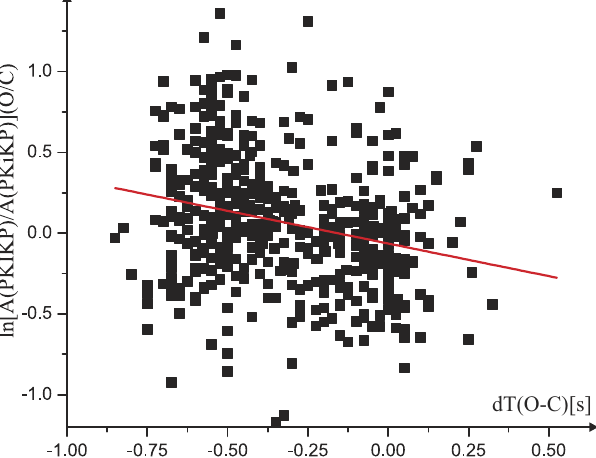
Figure 2. Natural logarithm of the amplitude ratio values of PKIKP/PKiKP (Observed/Computed) vs. the differential times from 548 high ( > 5) signal-to-noise observations. R-square value of the linear regression is equal to 0.08, indicating a large variance in the data (R-squared = 1 for a linear